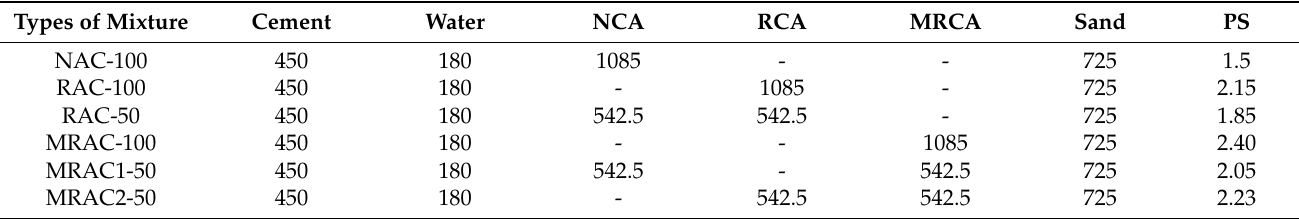
Table 4. Mixture proportions of concretes (kg/m 3